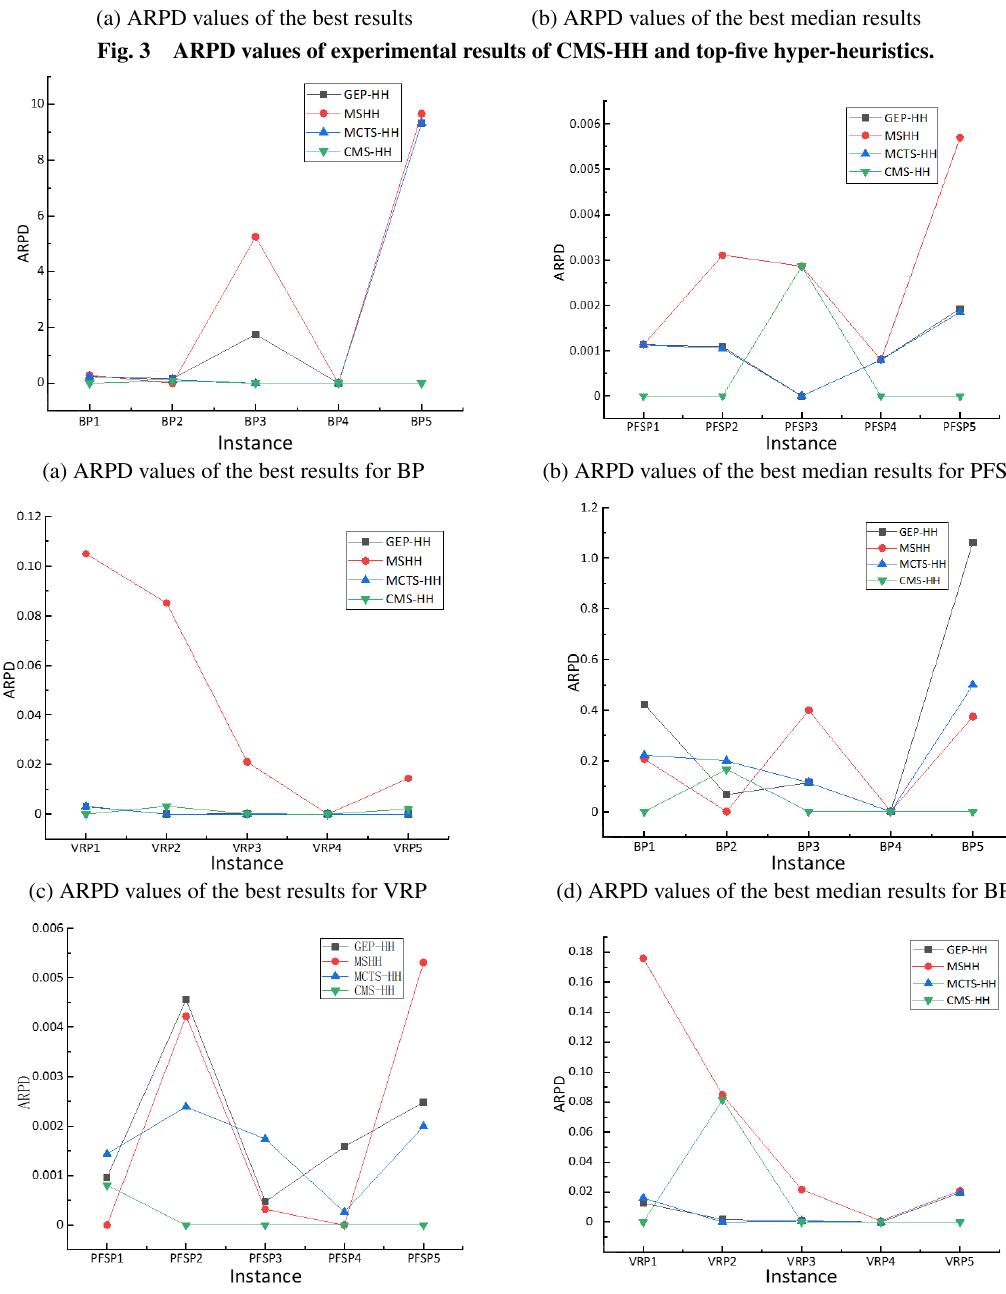
Fig. 4 ARPD values of experimental results of CMS-HH and state-of-the-art